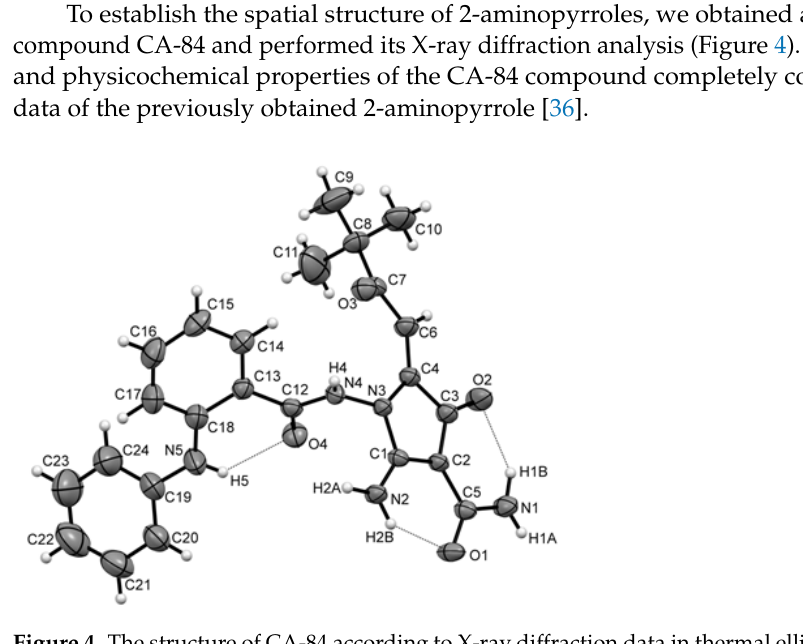
Figure 4. The structure of CA-84 according to X-ray diffraction data in thermal ellipsoids of 50% probability.